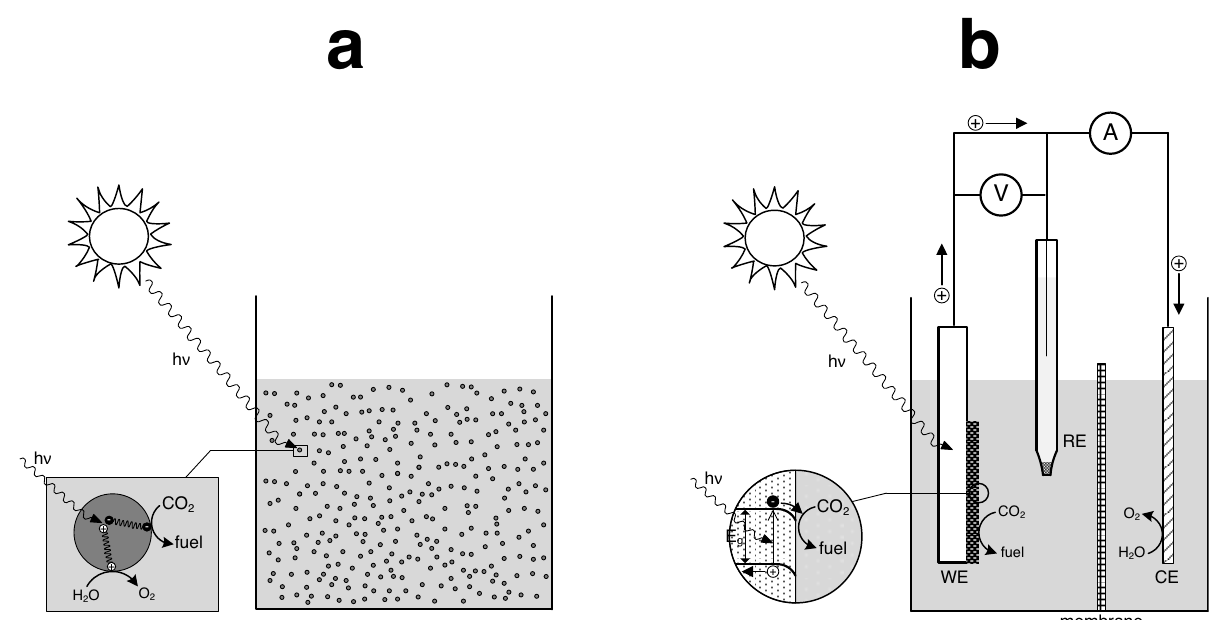
Figure 1: ( a ) Schematic of a photocatalytic cell, where semiconductor particles are suspended in a CO 2 - containing electrolyte. Each particle acts as tiny photoelectrolysis cells where both reduction and oxidation reactions take place. ( b ) Schematic of a typical two - compartment, three - electrode cell construction of a photocathode - driven PEC cell for CO 2 reduction. Absorption of light ( h ν ) more energetic than the band gap ( E g ) of the photocathode results in the generation of electron - hole pairs, separated by the electric fi eld ( as shown by the bending of the bands ) at the semiconductor - electrolyte interface. Electrons are transported to the surface, where they participate in the reduction of CO 2 , while the holes migrate to the back contact and to the counter electrode ( CE ) via the external circuit, where they are consumed in the oxidation reaction ( in aqueous electrolytes, the oxygen evolution reaction ) , completing the fl ow of current in the cell. The addition of a reference electrode ( RE ) allows the potential of the WE ( or more speci fi cally, the Fermi level of the photocathode ) to be controlled via a potentiostat, which is useful in the investigation of PEC systems. ( Adapted with permission from ref. [ 14 ] . Copyright © 2015, American Chemical Society )